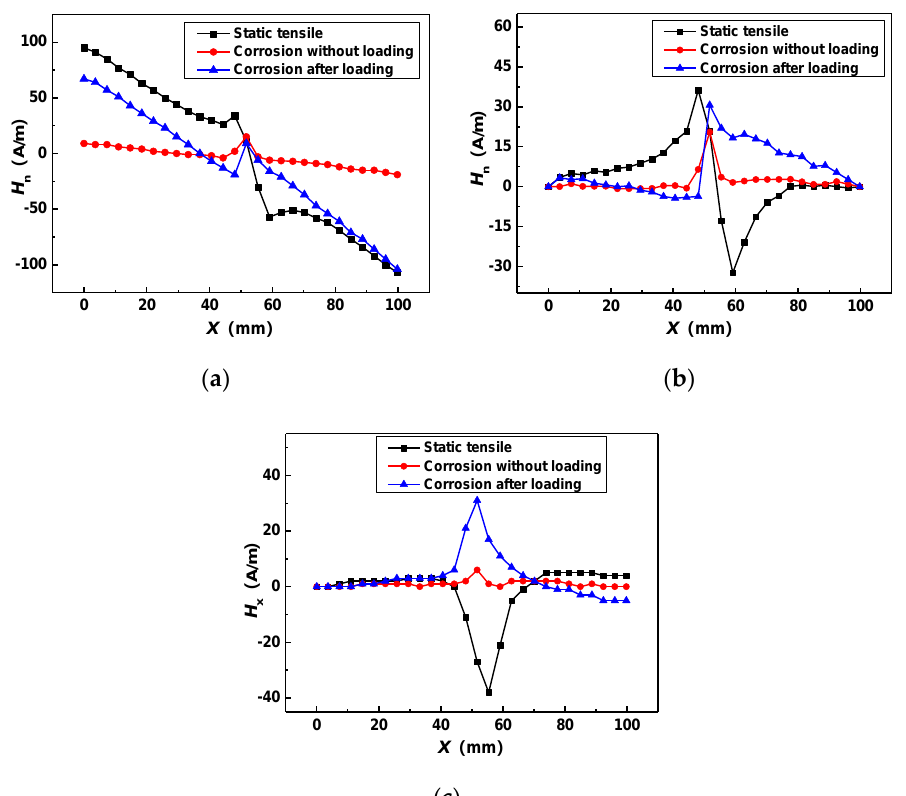
Figure 9. Comparison of H n and H t in the last stage in three experiments. ( a ) The normal components H n ; ( b ) the normal components H n (subtracting baseline amplitude value); ( c ) the tangential component H t (zero in baseline amplitude value).